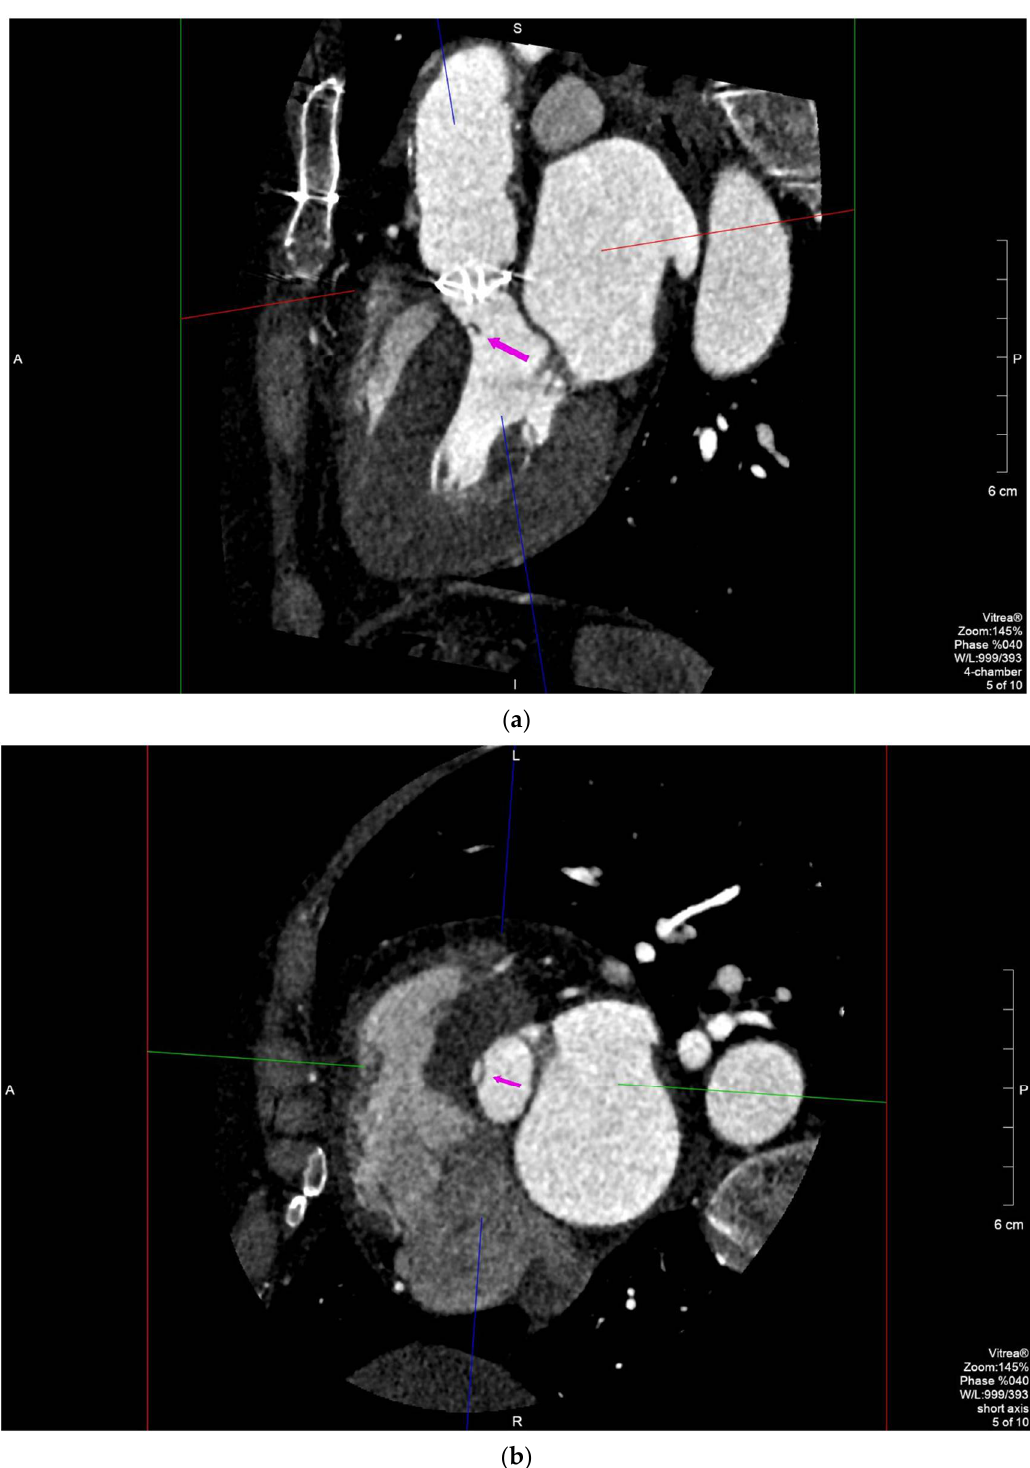
Figure 2. Long-axis ( a ) and short-axis ( b ) MPR focusing on the subaortic membrane (arrow) located 7 mm below the aortic annulus, with the maximum thickness of 5 mm and hemicircumferential extension along the interventricular septal surface.